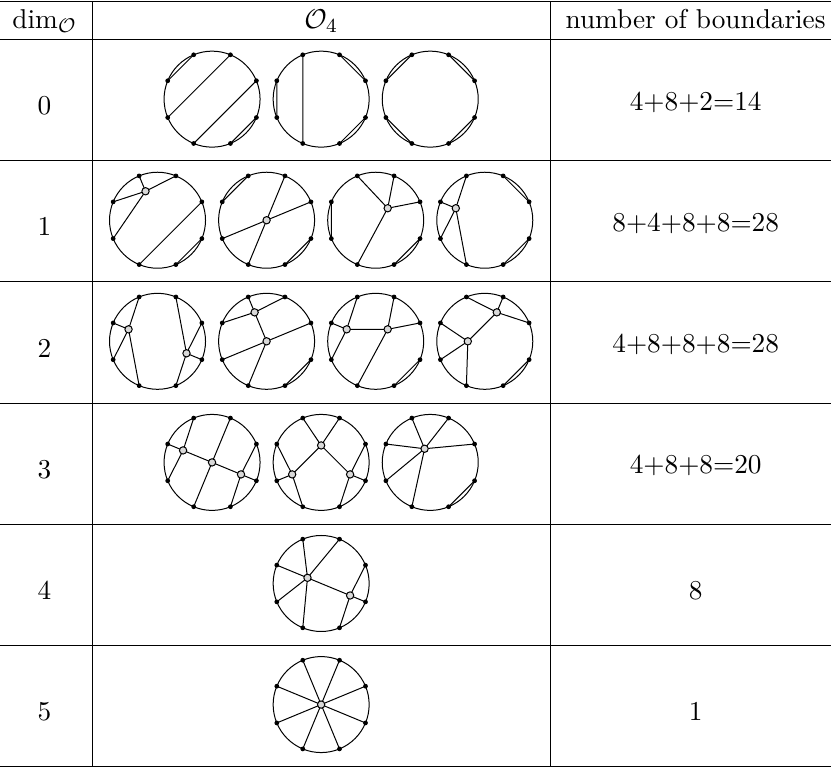
Table 1 . All types of OG forests that appear in the boundary stratification of O 4 . We find